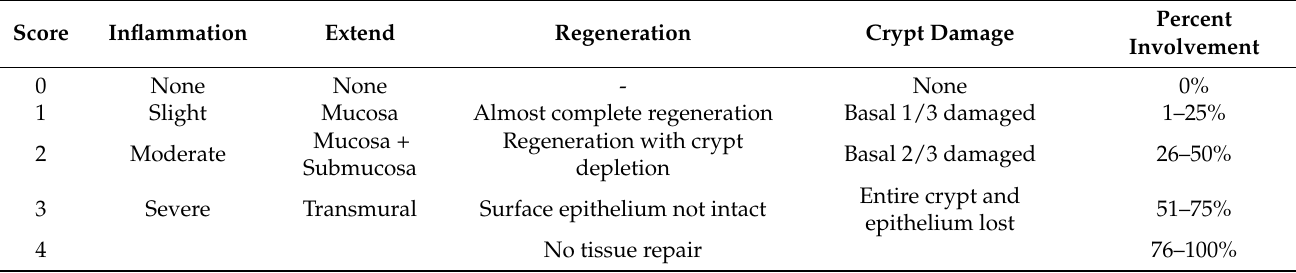
Table 2. Histological score to quantify the degree of